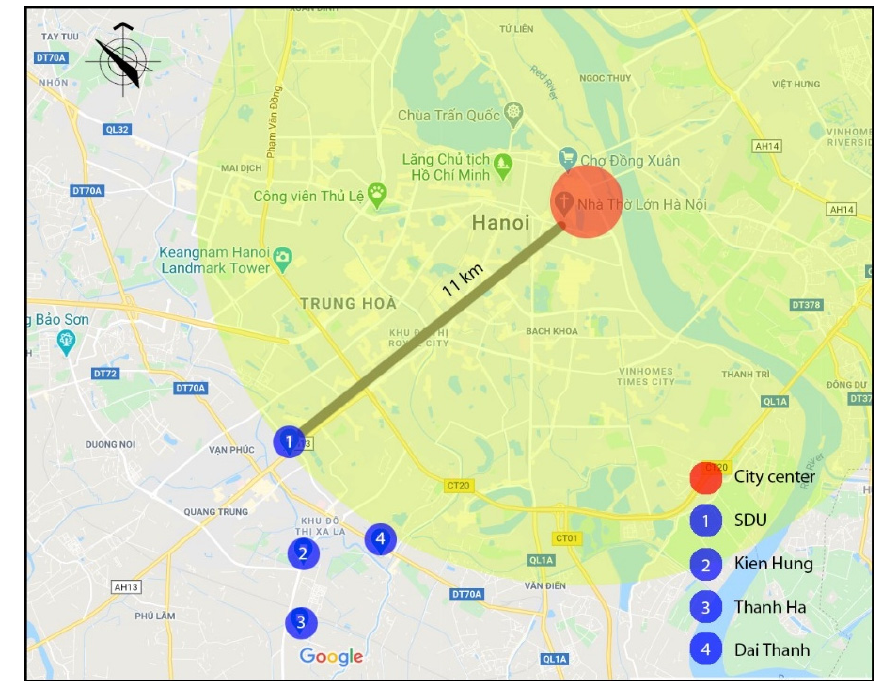
Figure 1. Location of the four neighborhoods. Source: the authors.